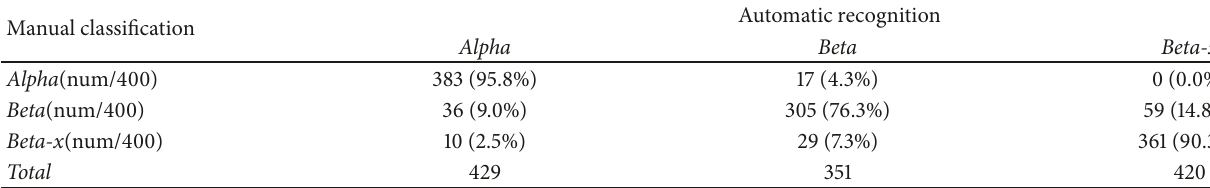
Table 5: Details of Model A Classification Results.